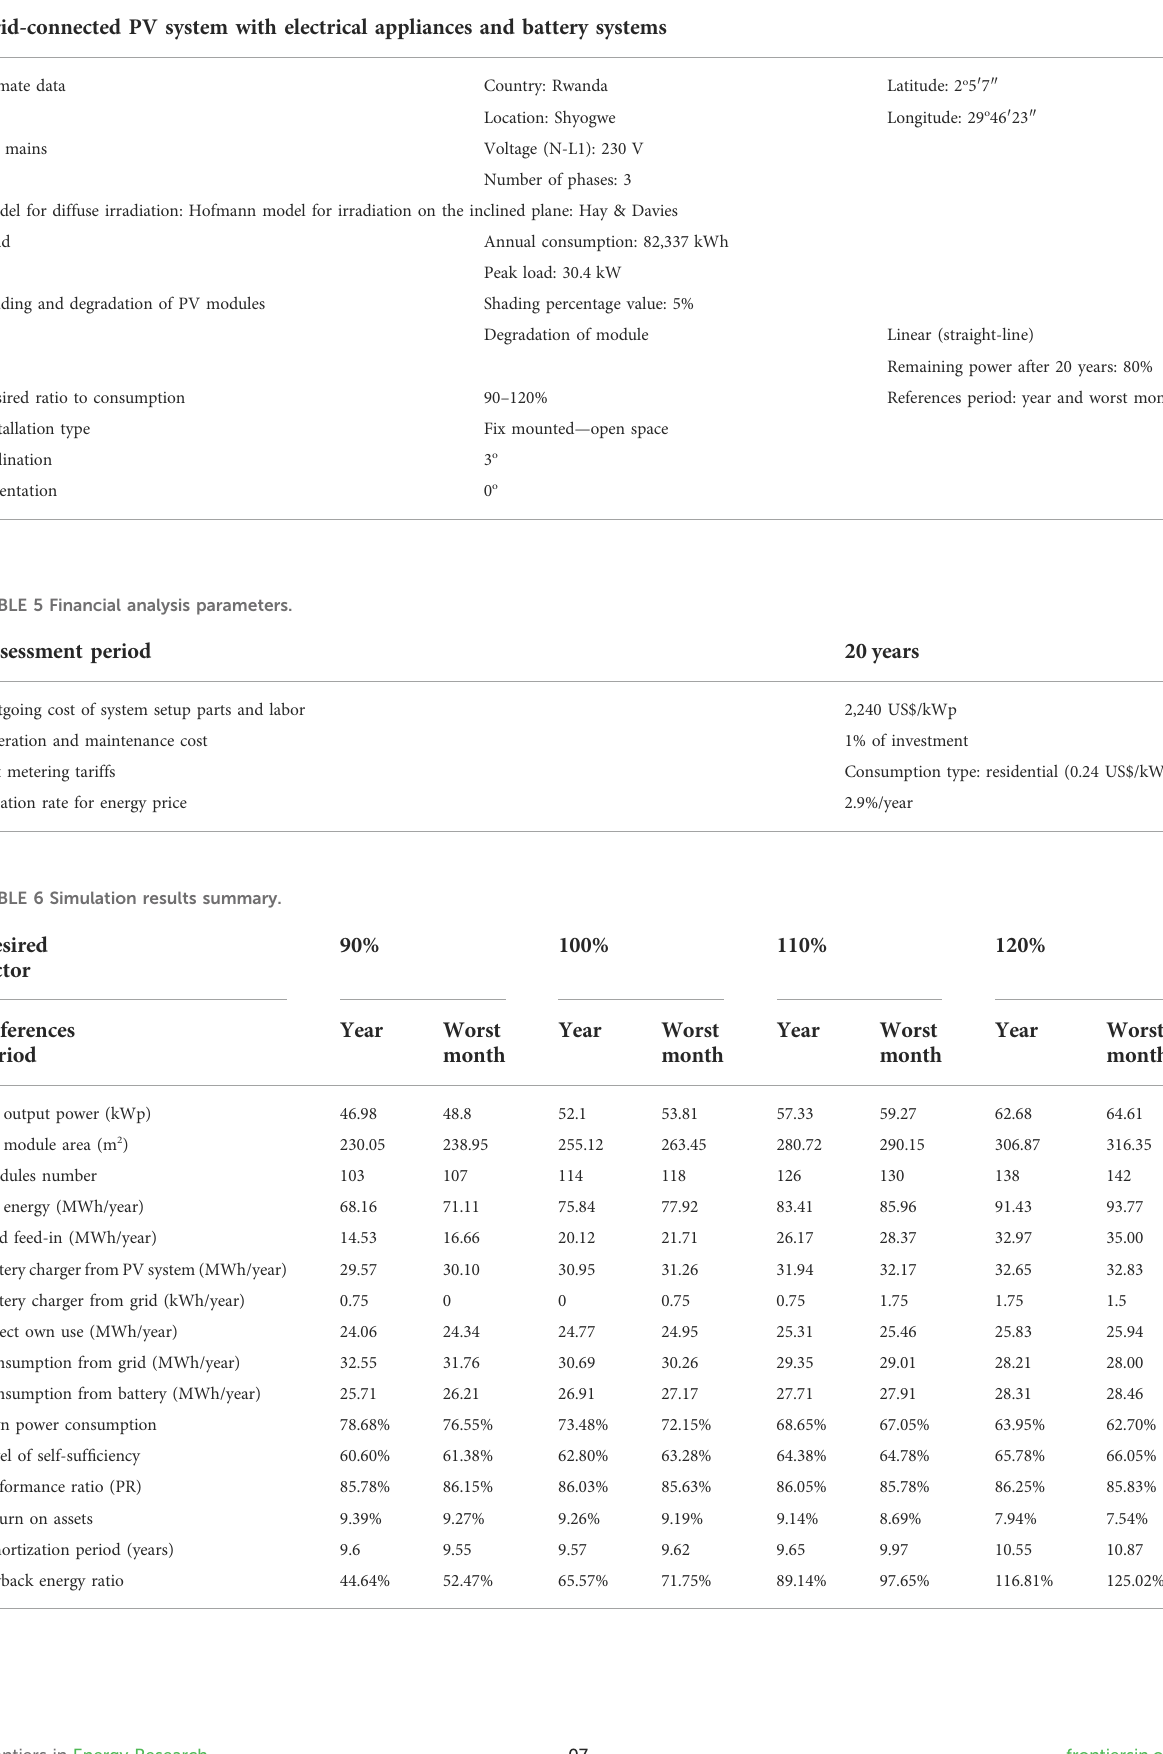
TABLE 4 Technical parameters for PV system design and simulation.